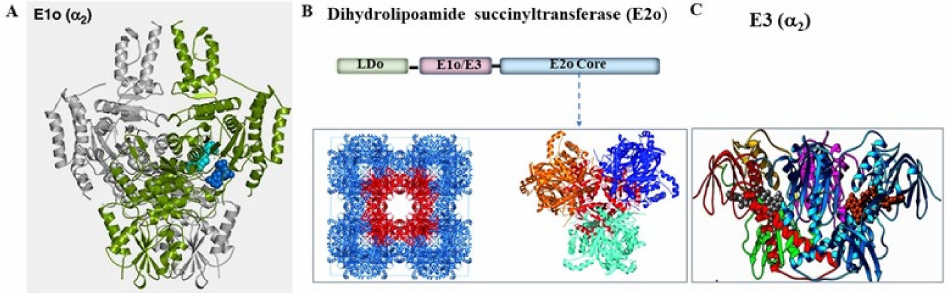
Figure 1. Structures of the globular components of the E. coli OGDH multienzyme complex. ( A ) X-Ray structure of the E1o ∆ 77 homodimer with monomers shown in green and gray (PDB ID: 2JGD) [39]. ( B ) Structures of the E. coli E2o. (Top) Domain structure of the E. coli E2o monomer. (Bottom, right): X-ray structure of the E. coli E2o trimer with each monomer shown in blue , orange and cyan (PDB ID: 1C4T) [66]. (Bottom, left) The 24-mer molecular assembly of the E. coli E2o core domain (PDB ID:1scz) [49]. ( C ) X-ray structure of the E3 homodimer with each monomer shown in cyan and in blue (PDB ID: 4JDR)